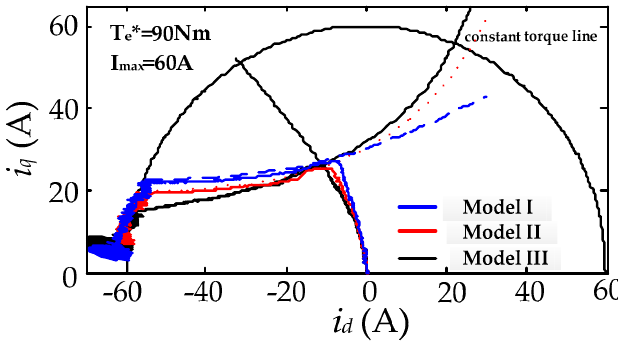
Figure 9. Simulation result of current trajectory when torque command is limited to 90 nm.